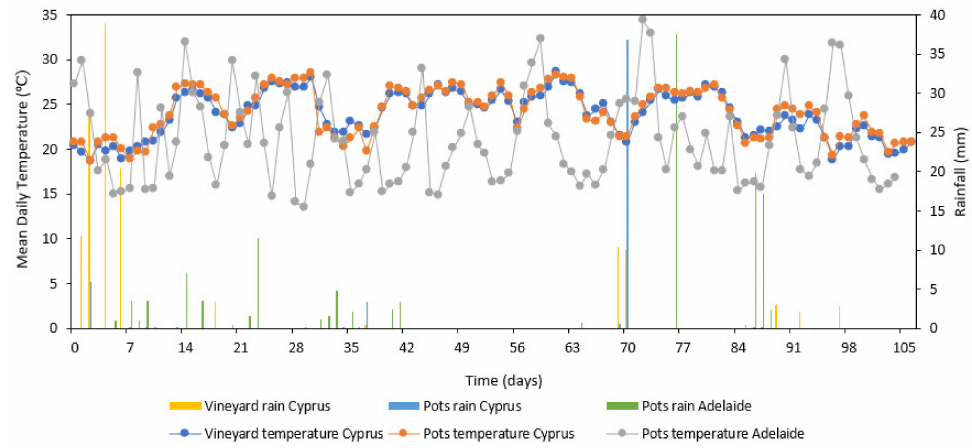
Figure 4. Climate and rainfall data for Cyprus Xynisteri vineyard site (Kato Mylos), Cyprus potted trial (Omodhos) and Adelaide Waite Campus, Australia for the testing periods 2019 and